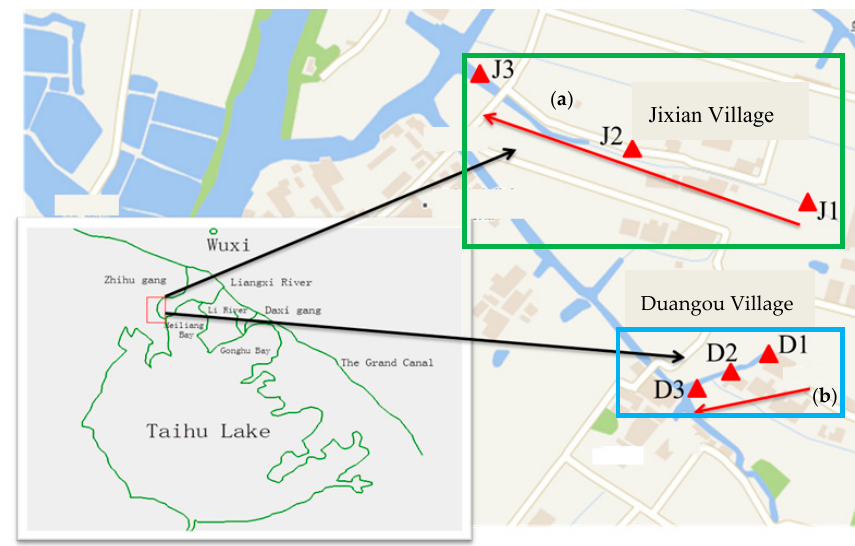
Figure 1. Map of the creeks and sample sites. ( a ) Creek polluted by sewage (in blue rectangle); ( b ) creek polluted by industrial effluent (in green rectangle). Table 1. Hydrological data of two creeks.